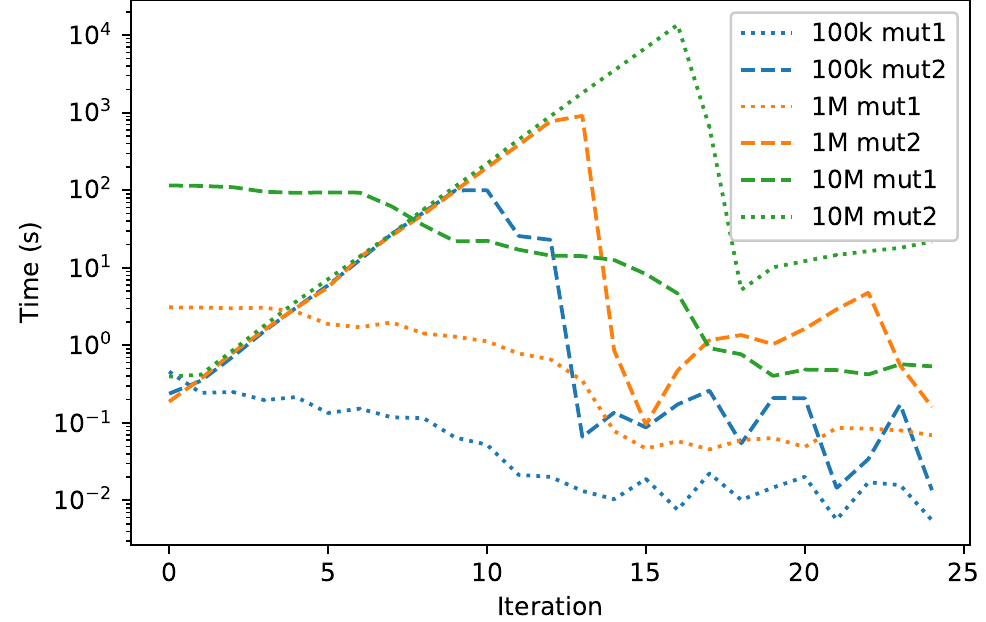
Figure 3. Execution time per iteration (mean across 10 runs) for the two mutation operators on the casting scheduling problem in three different dimensionalities.